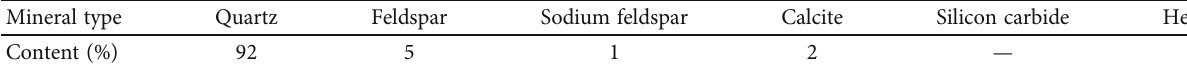
Table 3: Experimental groups.